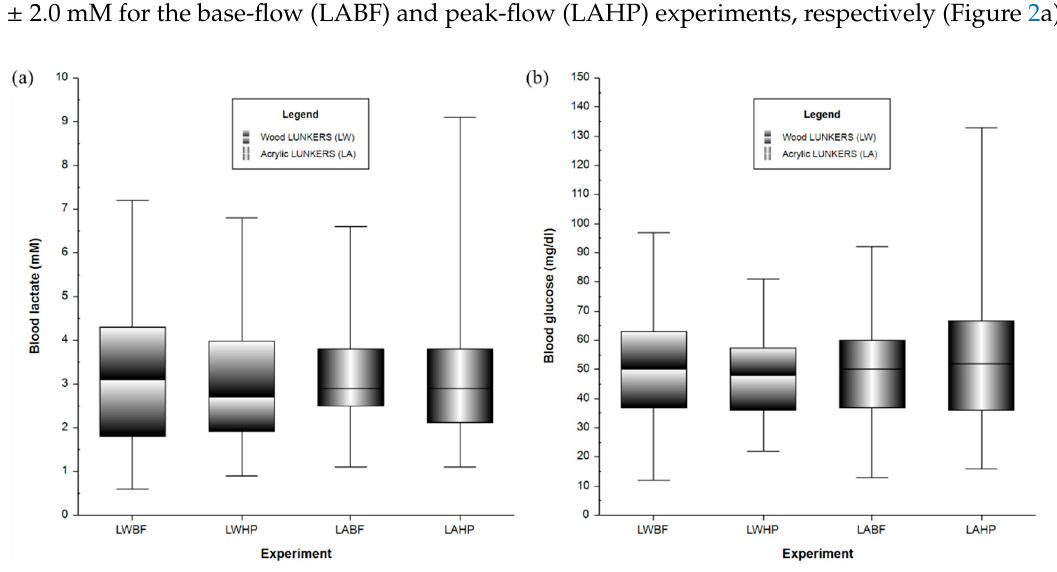
Figure 2. Boxplots of the variation of ( a ) blood lactate (mM) and ( b ) blood glucose (mg / dL) levels for L. bocagei (n = 45) for both base-flow (BF) and hydropeaking (HP) events, and for both L-structure experiments (LW: Wood and LA: Acrylic).